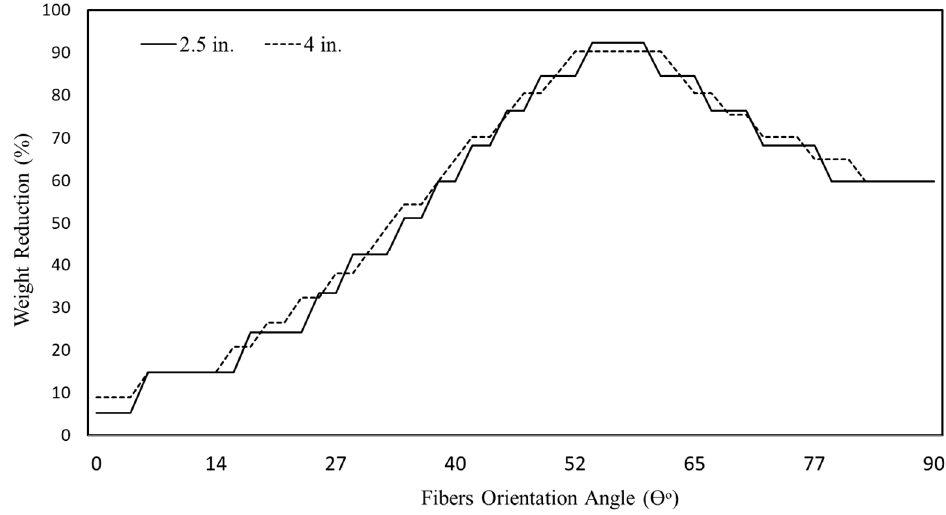
Figure 11. The weight reduction of 2.5” and 4” PVs made of IM7/977-3 compared to ones made of SST 316L for different fiber angles.